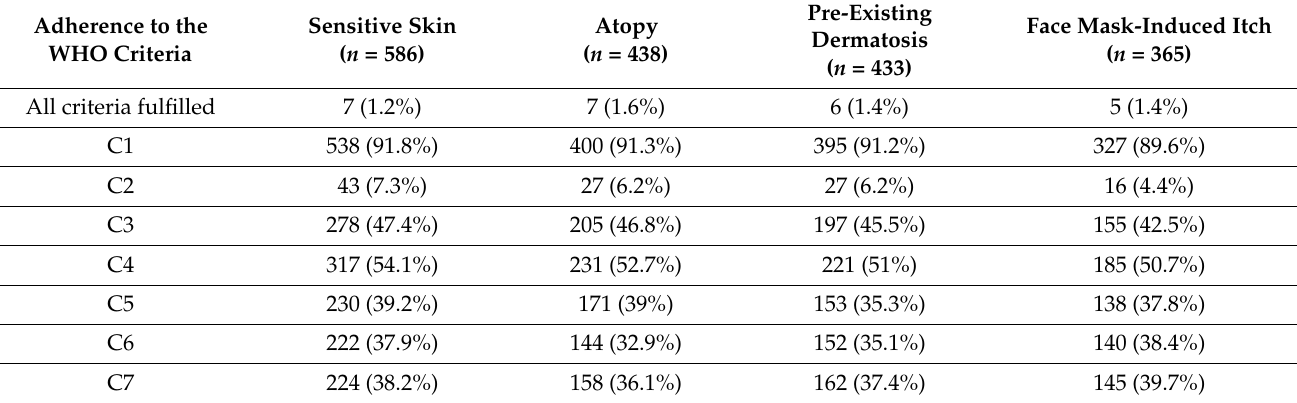
Table 5. Adherence to the WHO criteria according to the presence of skin-related